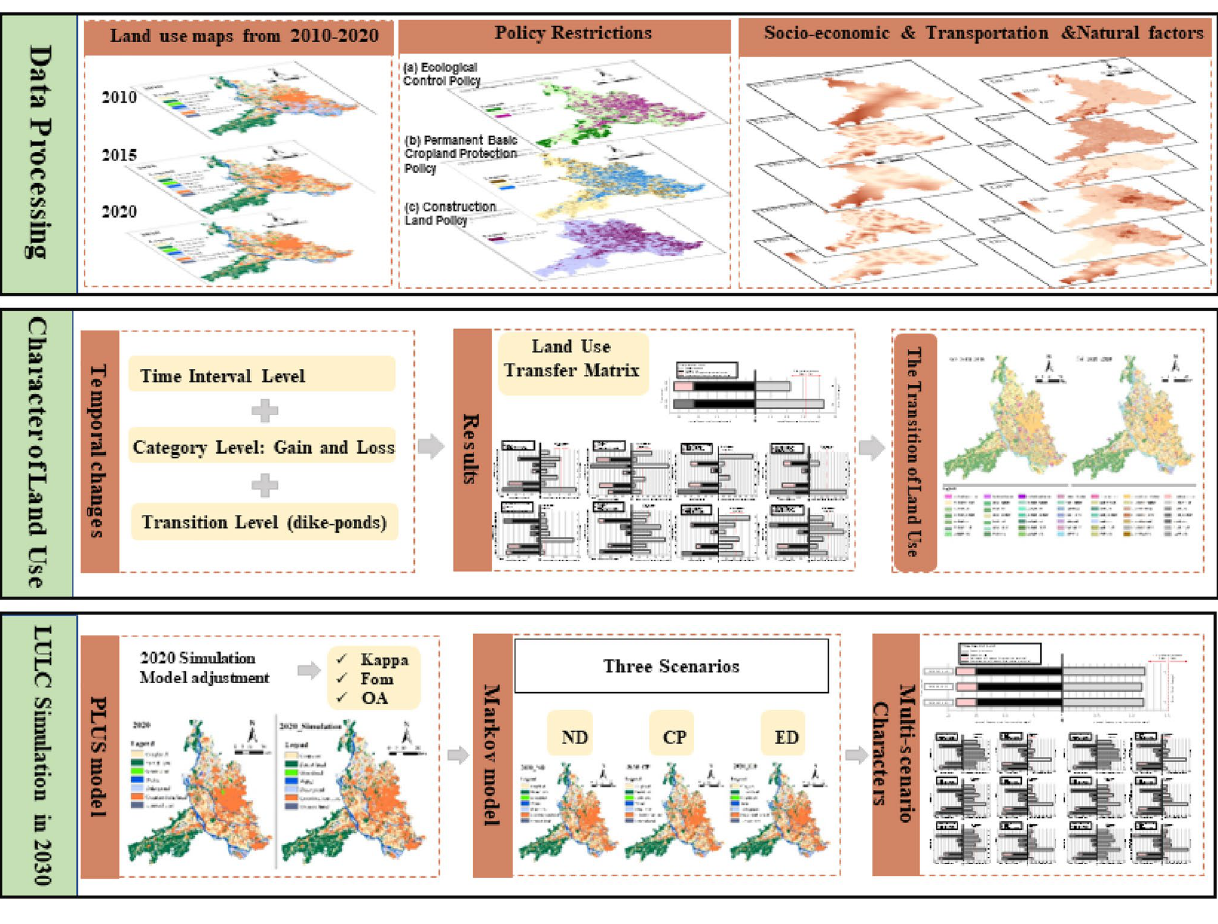
Fig.3 Research framework